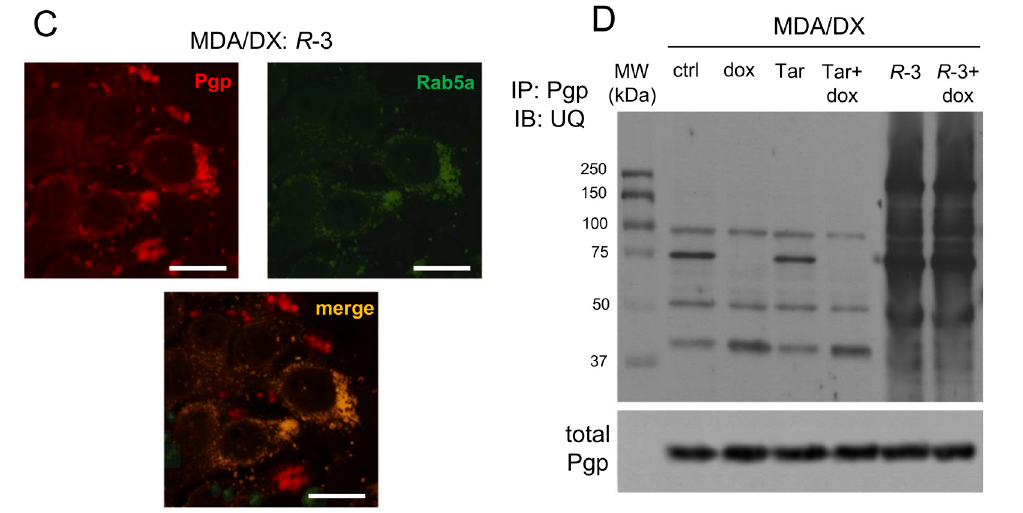
Figure 4. R -3 disrupts Pgp-calreticulin interaction, favoring the internalization and ubiquitination of Pgp. Human triple-negative breast cancer MDA-MB-231 cells and their doxorubicin (DX)-resistant variant were incubated for 24 h in fresh medium (ctrl) or in medium containing 5 µ M doxorubicin (dox). When indicated, 75 nM Tariquidar (Tar) or 75 nM R -3 were added. ( a ) Proximity ligation assay between Pgp and calreticulin. Blank: cells incubated without primary antibodies. Blue signal: nuclear staining (DAPI). Green signal: Pgp / calreticulin interaction. The image is representative of 1 out of 3 experiments. A minimum of 5 fields / experiment was examined. Bar: 10 µ m (10 × ocular lens; 63 × objective lens). ( b ) Plasma membrane extracts were immunoblotted and decorated to detect Pgp or CRT, or immuno-precipitated (IP) with an anti-CRT antibody, then immunoblotted (IB) with an anti-Pgp antibody. no Ab: MDA-MB-231 and MDA-MB-231 / DX samples treated with doxorubicin, immuno-precipitated without antibodies. An aliquot of the extracts before the immunoprecipitation was probed with an anti-pancadherin antibody, as control of equal protein loading. The figure is representative of 1 out of 3 experiments. ( c ) MDA-MB-231 / DX cells were incubated 24 h with 75 nM R -3. During the last 18 h, cells were transfected with an expression vector for GFP-conjugated Rab5a, to label early endosomes. Subsequently, cells were labeled with an anti-PE-Pgp antibody. Immunofluorescence detection of Pgp co-localized with Rab5a was achieved by confocal microscope analysis. The image is representative of 1 out of 3 experiments. A minimum of 5 fields / experiment was examined. Bar: 10 µ m (10 × ocular lens; 60 × objective lens). ( d ) Whole cell extracts of MDA-MB-231 / DX cells were immunoprecipitated with an anti-Pgp antibody, then immunoblotted for ubiquitin (UQ). An aliquot of the extracts before the immunoprecipitation was probed with an anti-Pgp antibody, as index of the total amount of Pgp immunoprecipitated in each sample. The figure is representative of 1 out of 3